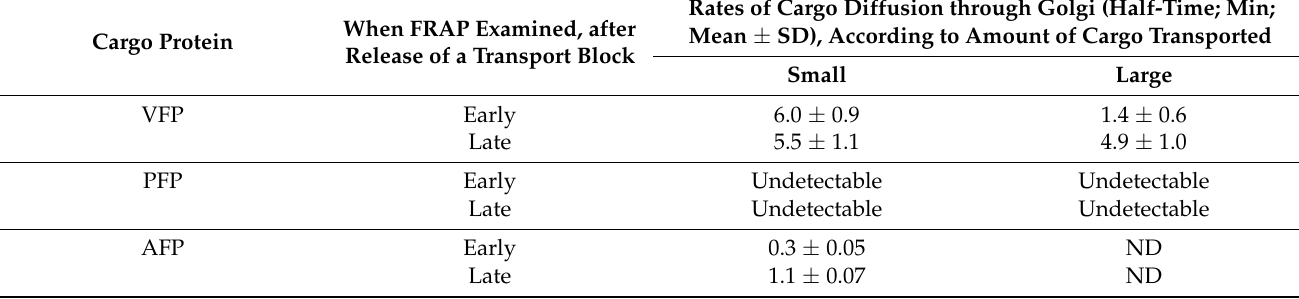
Table 2. Rates of cargo diffusion along the Golgi ribbon (half-time in minutes: mean ± SD).